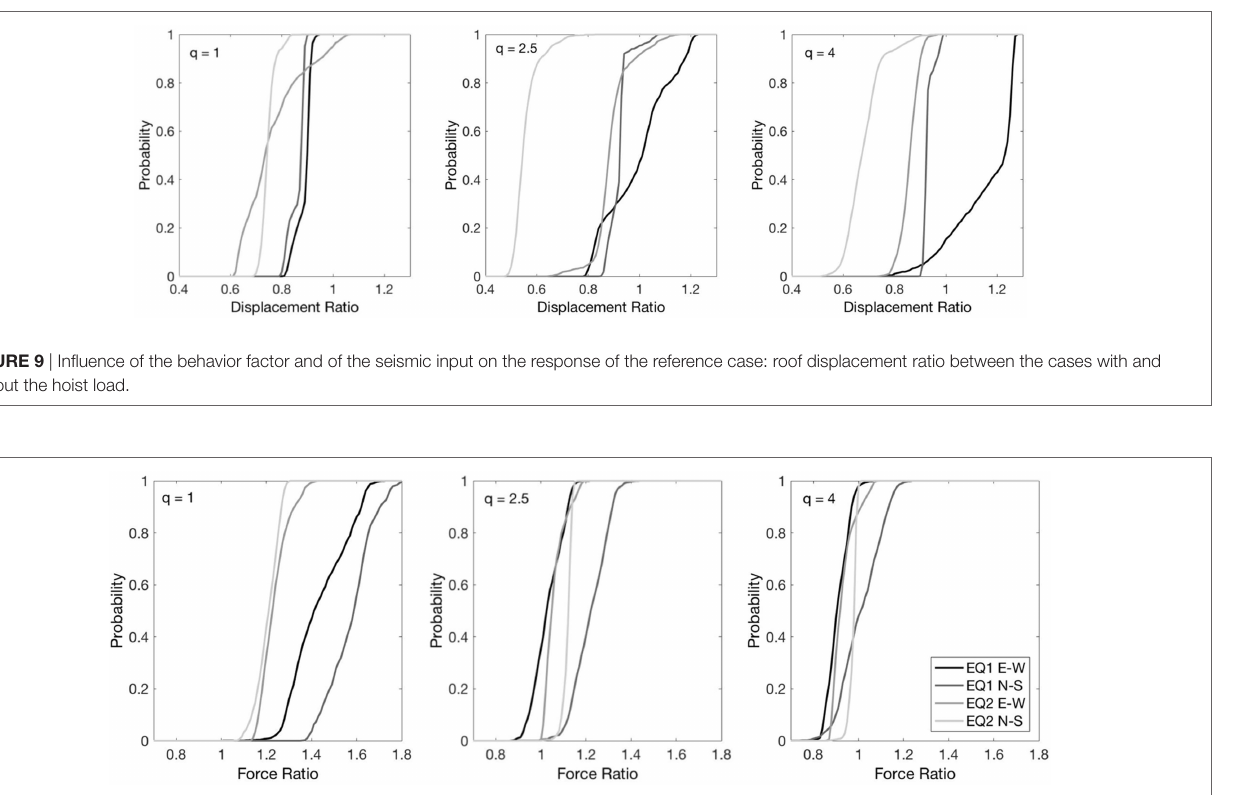
FigUre 10 | Influence of the behavior factor and of the seismic input on the response of the reference case: ratio of the horizontal component of the cable tension compared to the results obtained from a response-spectrum analysis.